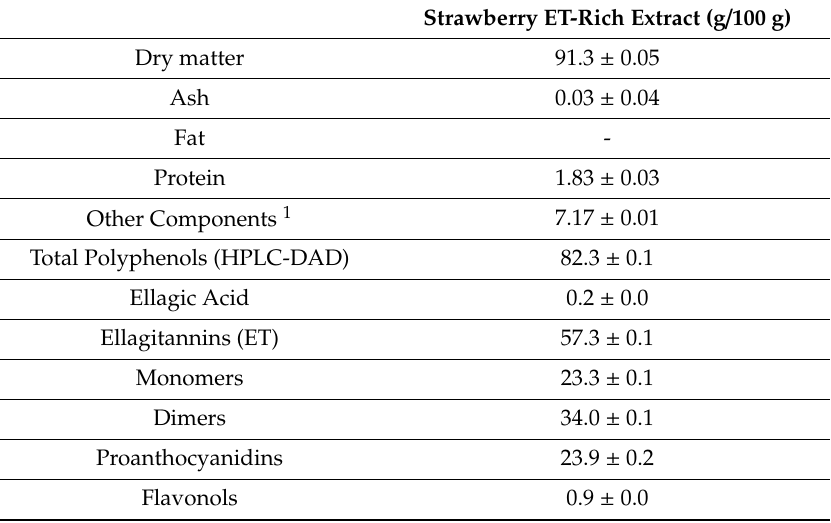
Table 6. Chemical composition of the strawberry ellagitannins (ET)